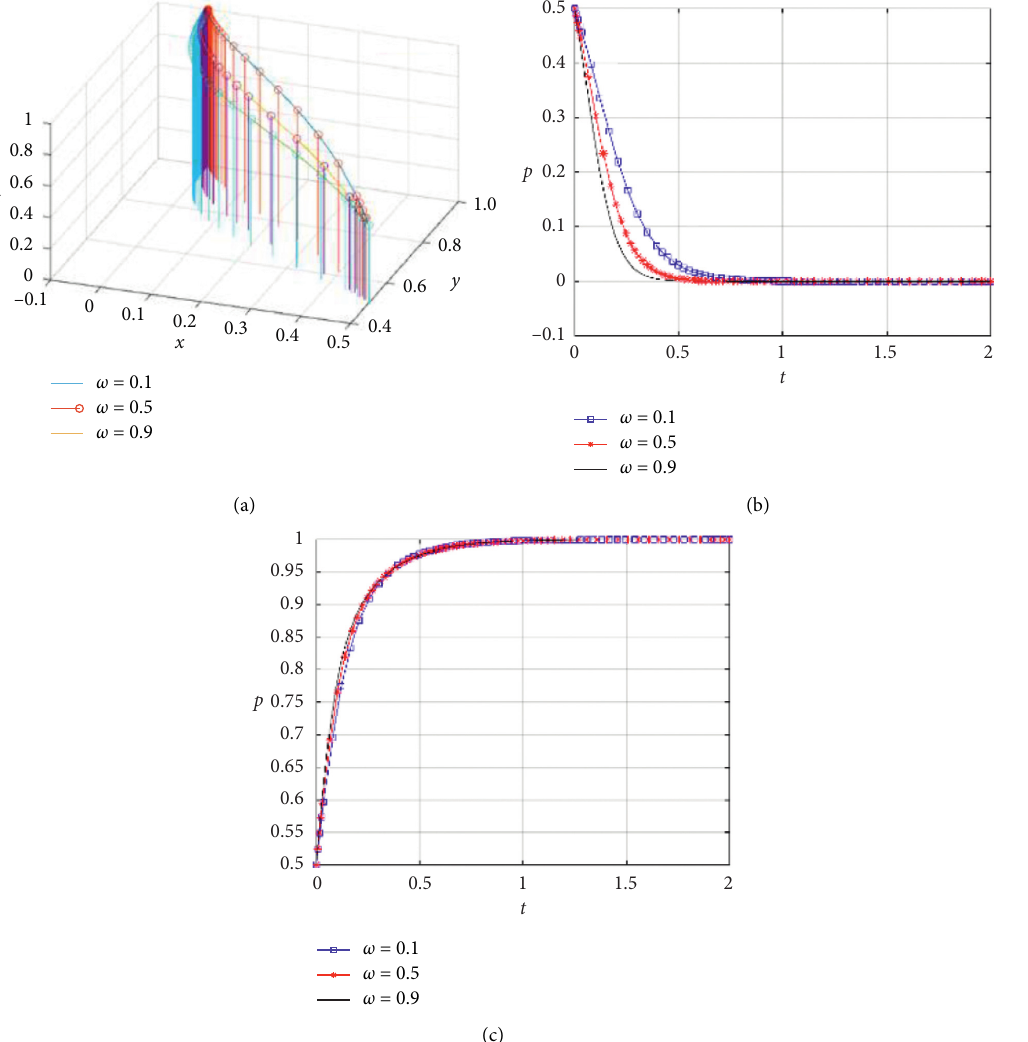
Figure 6: Simulation diagram of evolution path of each subject’s behavior under different enterprise subsidies. (a) The evolution of the system under different government punishment coefficients. (b) Simulation of evolution path of government behavior under different government punishment coefficients. (c) Simulation of evolution path of enterprise behavior under different government punishment